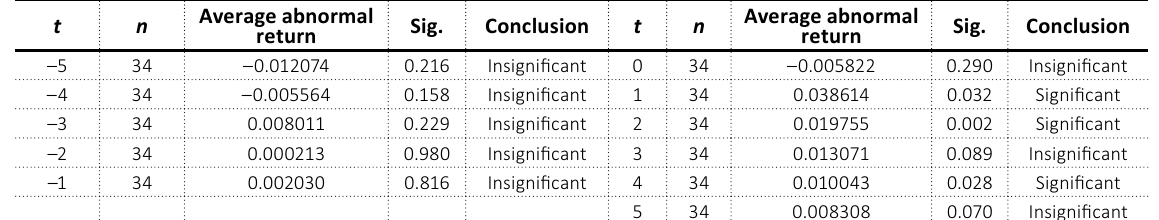
Table 1. Different test results before and after announcement of increase in dividends based on average abnormal return on the period 2017